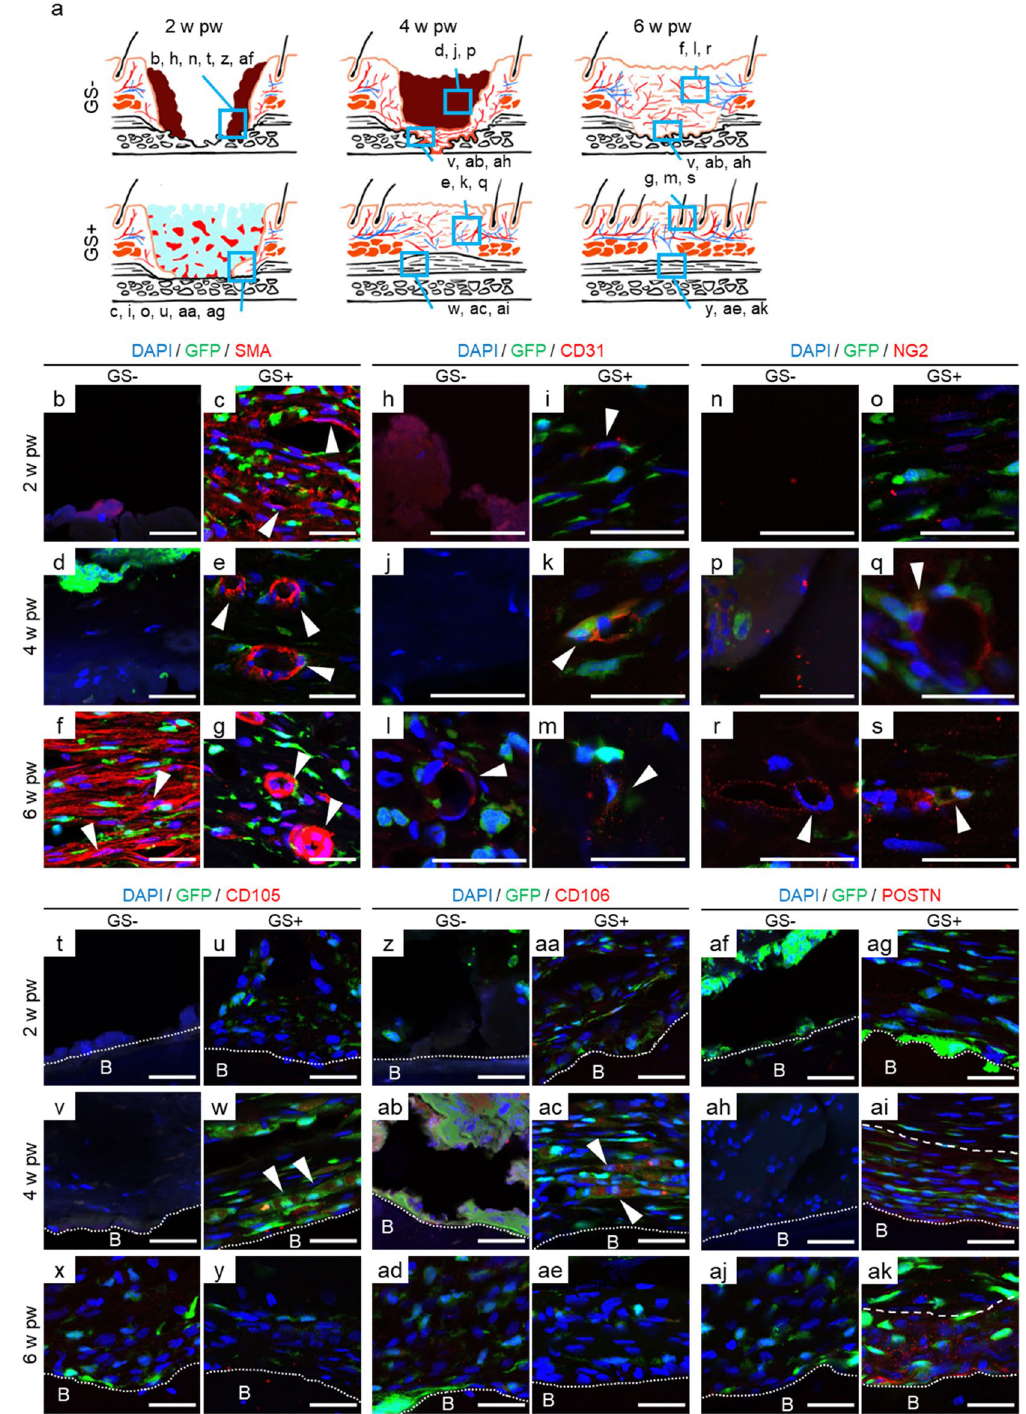
Figure 3. Vasculogenesis in heterogeneous tissues led by GS application in BMT rats. ( a ) Schematic drawings of the deep wounds with or without GS application is shown at various time points. ( b – s ) Neovessel formation in the dermis of GS (+) rats. ( b – g ) Immunohistochemistry with anti-SMA antibody (red) reveals luminal structures contributed by BMDCs (green) in GS (+) rats, whereas SMA-positive BMDCs exhibit fibre-like patterns at 6 w pw in GS (−) rats. ( h – m ) CD31 stains BMDCs in luminal structures in GS (+) rats, which is never present in GS (−) rats. ( n – s ) NG2, a periderm marker (red), is positive for BMDCs surrounding newly formed endothelial cells in GS (+) rats but not in GS (−) rats. ( t – ae ) Vasculogenesis occurs in GS adjacent to bone. CD105 and CD106, markers of vascular endothelium, are stained in BMDCs at 4 w pw in GS (+) rats (arrowheads in v and ab ). ( af – ak ) Periostin is positive in the tissue adjacent to bone after 4 w pw in GS (+) rats (between dot line and dash line in ah and aj ) but not present in GS (−) rats. n = 4 for each. The experiments were repeated twice. Scale bars, 30 μm. Dotted lines show the boundary of the bone cortex. The dashed line shows the apical boundary of the periosteum. B